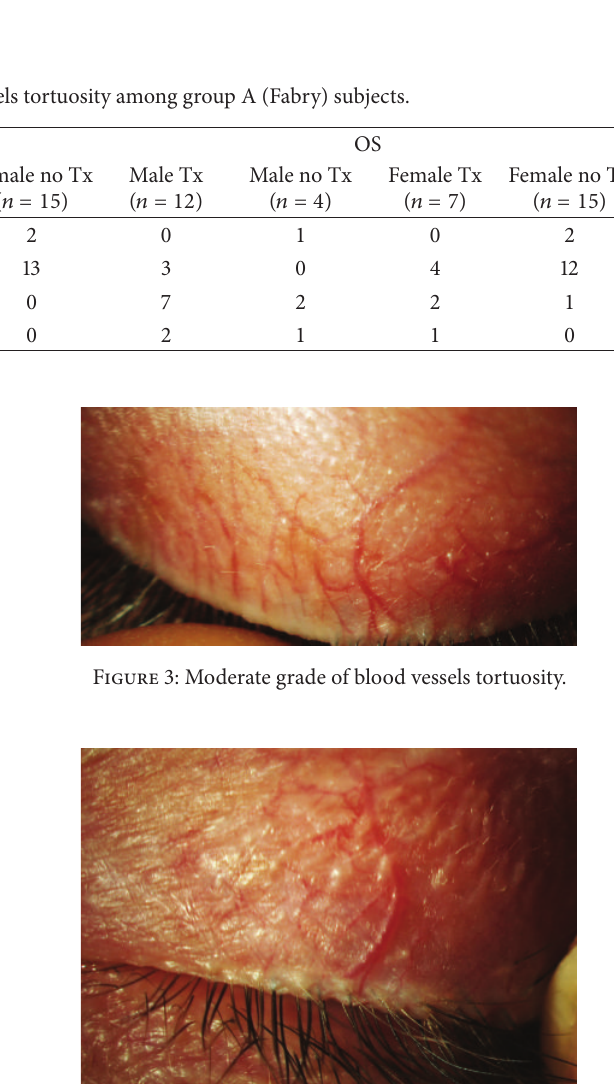
Figure 2: Low grade of blood vessels tortuosity as seen on the upper lid of a Fabry patient.